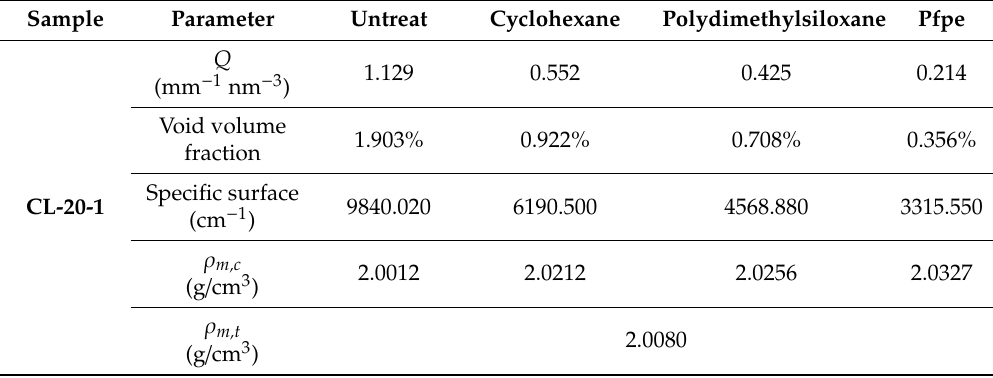
Table 2. Calculation results of parameters of CL-20-1 crystal under di ff erent